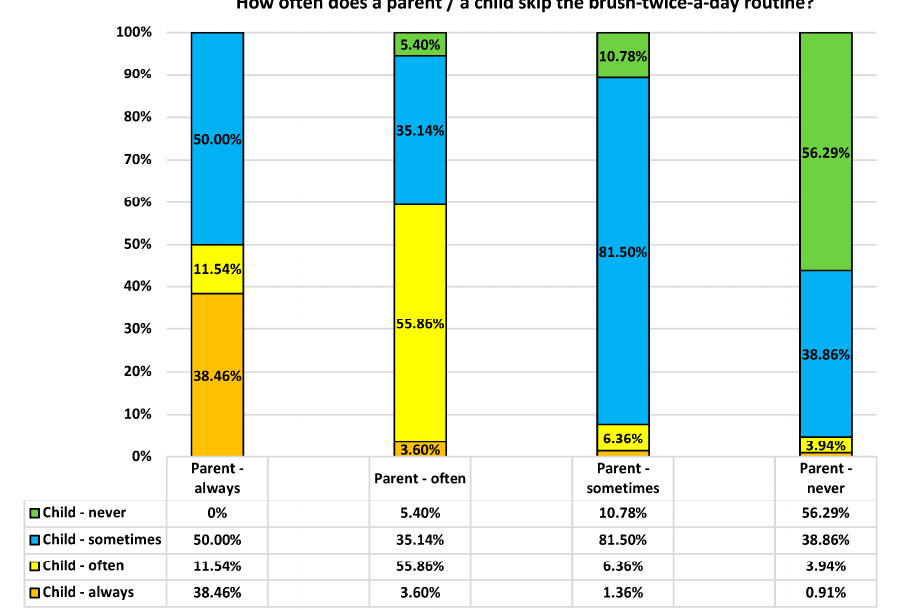
Figure 1. Skipping the twice-a-day toothbrushing routine: parents vs. their children.